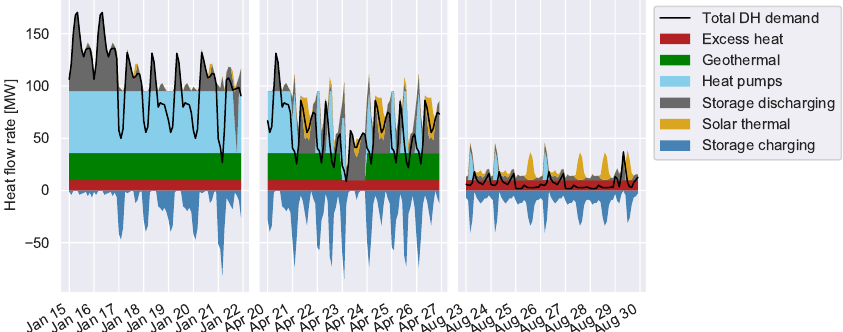
Figure 14. Detailed heating power plot of the maximum PEIS design for a winter, spring and summer week.